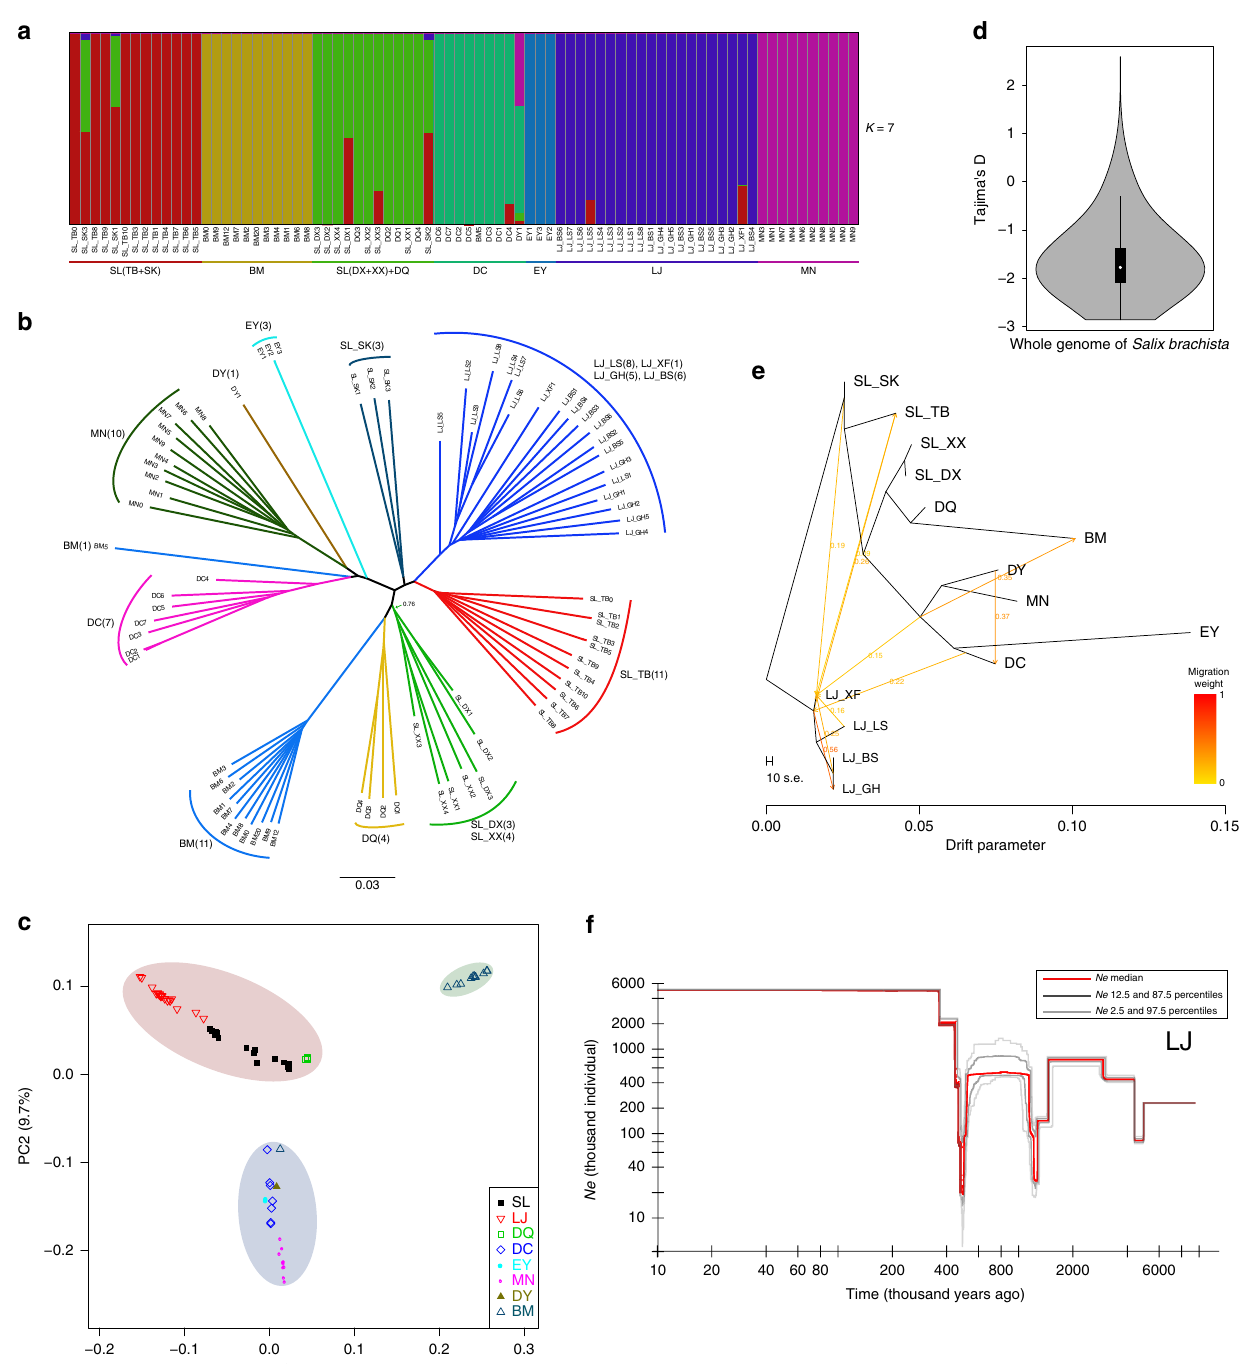
Fig. 3 Population genetic strucure and demographic history. a Genetic structure of Cushion willow. The length of each colored segment represents the proportion of the individual ’ s genome from K = 7 ancestral genetic groups. The populations grouped by county individual identi fi ers are indicated along the x -axis. b Neighbor-joining phylogenetic tree of Cushion willow based on SNPs from whole-genome resequencing. Branch lengths are scaled to genetic similarity ( p distance, see scale bar). c PCA plot of Cushion willow genetic variation. The fractions of the variance explained by eigenvector 1 and 2 are 11.0% and 9.7%, respectively. Each shaded area groups populations from the same region: pink for populations from northwest Yunnan at the center of the area sampled, blue for eastern peripheral populations, and green for the west most peripheral populations. d Violin plot of Tajima ’ s D in whole genome of Salix brachista . The width depicts a 90 0 -rotated kernel density trace and its re fl ection. Vertical black boxes denote the interquartile range between 25 and 75 percentiles, and the white point inside denotes the median. n = 168,546. e Detection of gene fl ow between Cushion willow populations. Lines represent gene fl ow, with arrows indicating the direction of gene fl ow. The horizontal scale bar at the bottom (drift parameter) shows a tenfold average standard error of the entries in the sample covariance matrix. The color scale shows the migration weight: red denotes strong gene fl ow, while yellow denotes weak gene fl ow. f Stairway plot showing historical changes in effective population size ( y -axis) for LJ population with a generation time of 10 years. Red, dark gray, and light gray lines denote the medians, 12.5 and 87.5 percentiles, 2.5 and 97.5 percentiles of population sizes, respectively. The source data underlying Fig. 3d are provided as a Source Data fi